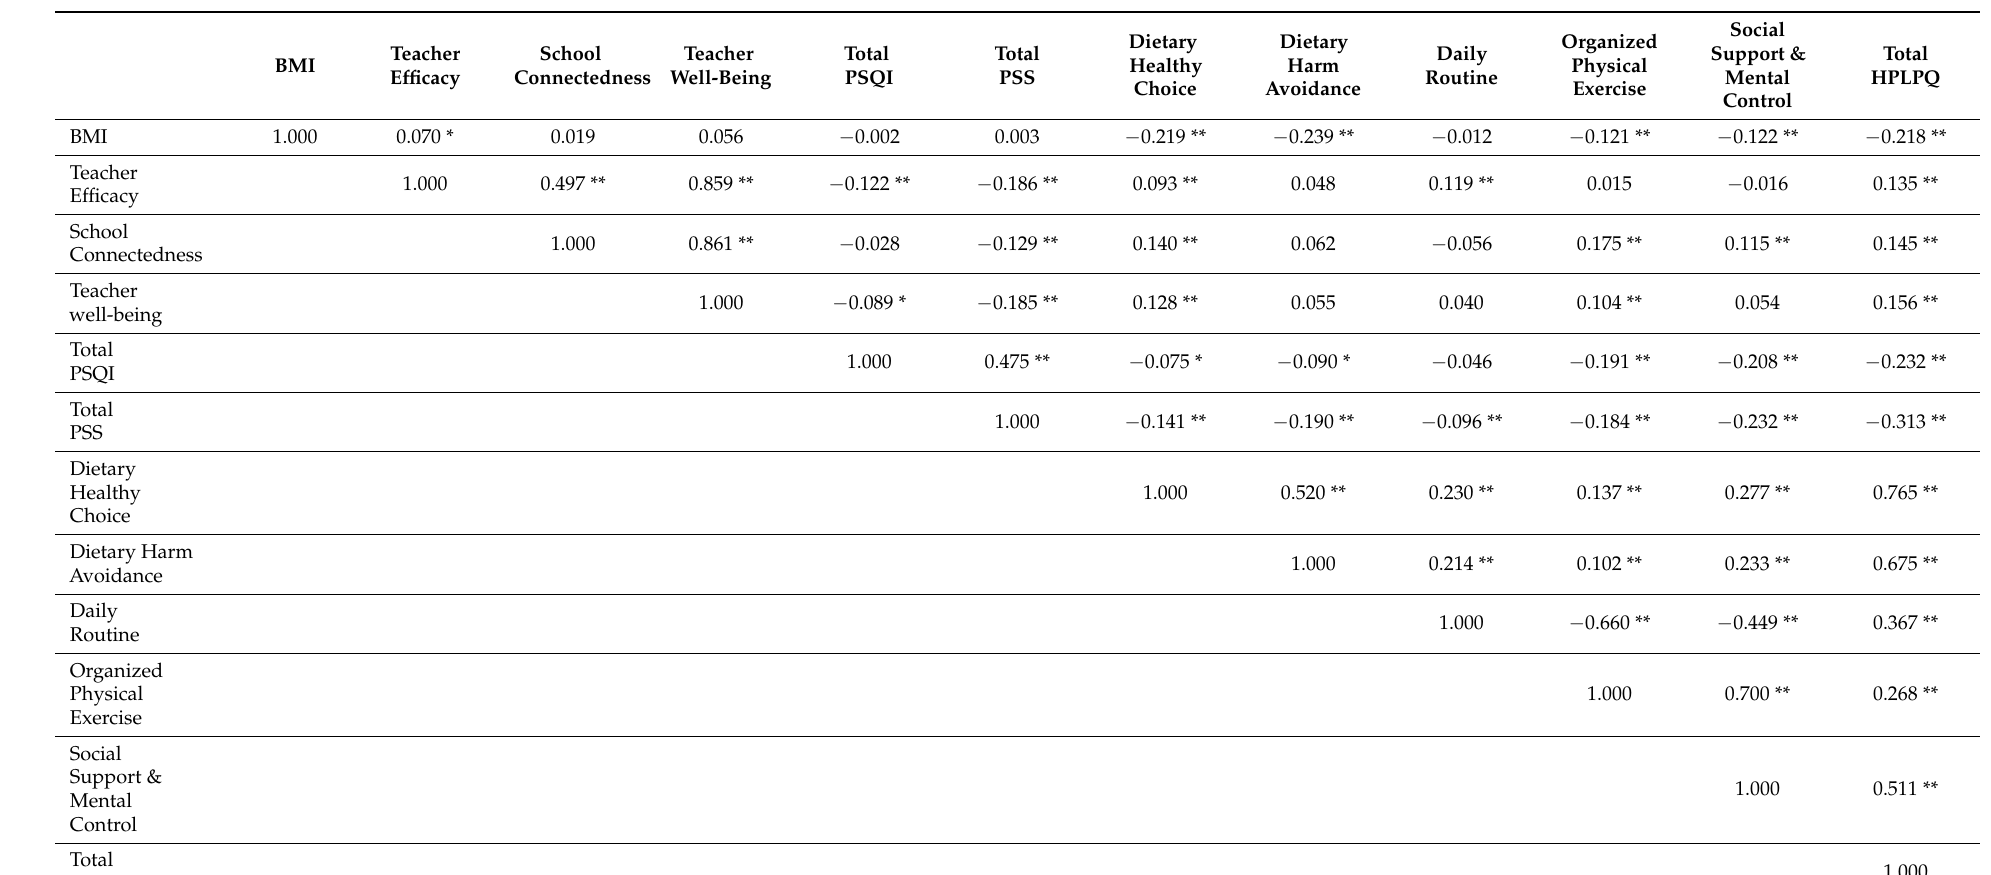
Table 3. Correlations between quantitative